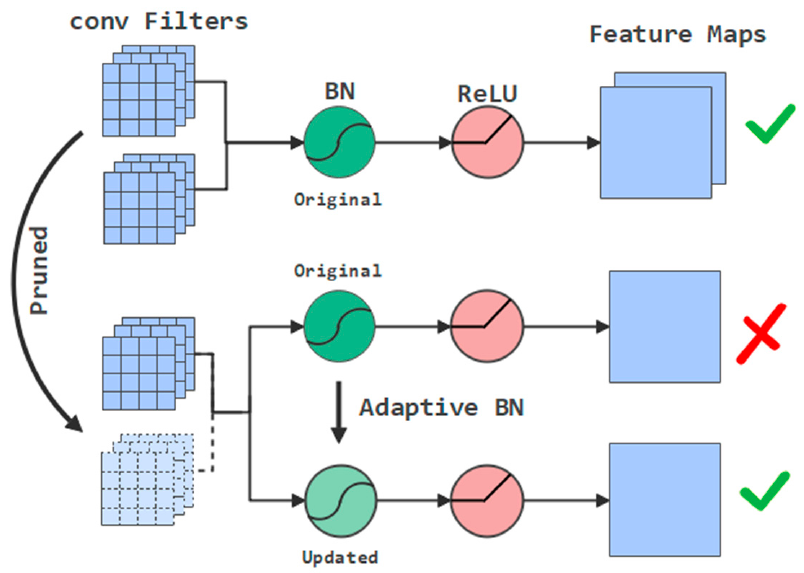
Figure 4. The dark green circle represents the original BN layer, which proceeds with the unpruned model. However, after being pruned, the structure of model has changed, and original BN layer cannot adapt the new model, whose results have poor accuracy. If the BN layer (marked by the light green circle) is updated by the Adaptive BN [9], the resulting accuracy will be better.